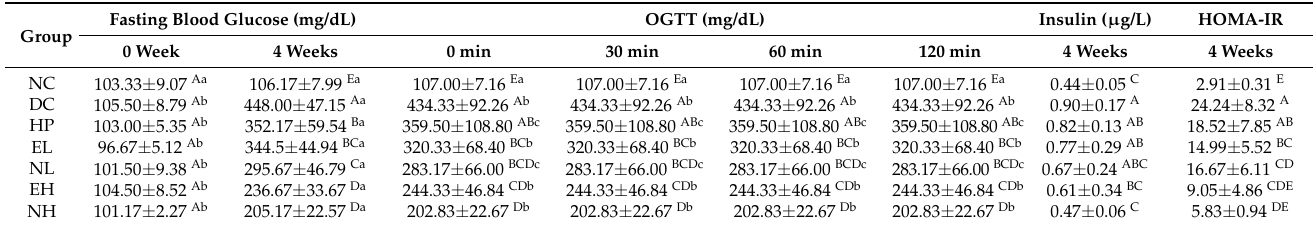
Table 9. Effects of administration of C. osmophloeum leaf extract, nanoemulsion and hydrosol on fasting blood glucose (FBG), oral glucose tolerance test (OGTT), serum insulin and HOMA-IR index in rats on a high-fat diet that received streptozotocin injection to induce